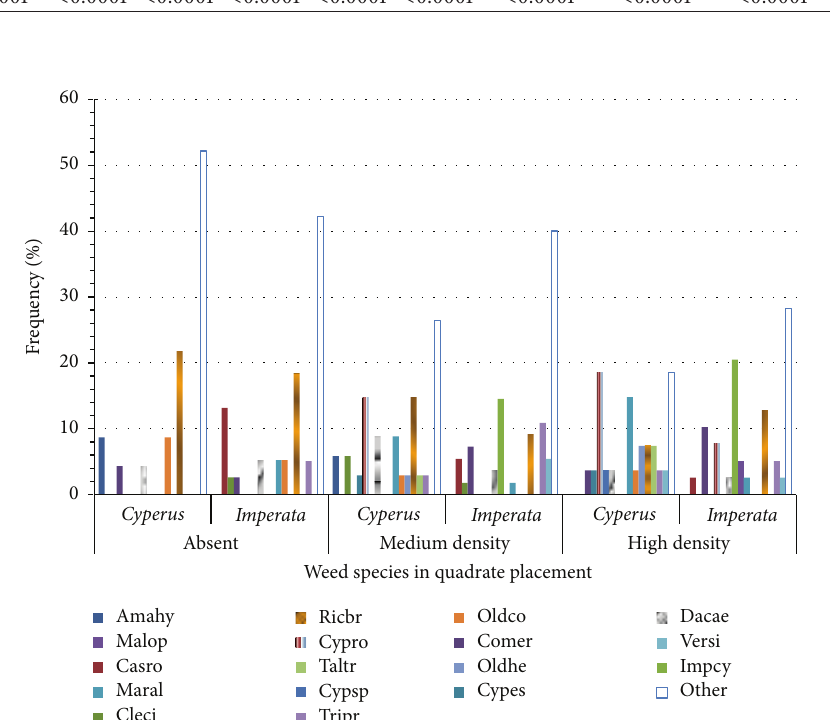
Figure 1: Weed specie average frequency in different placements of the quadrate.